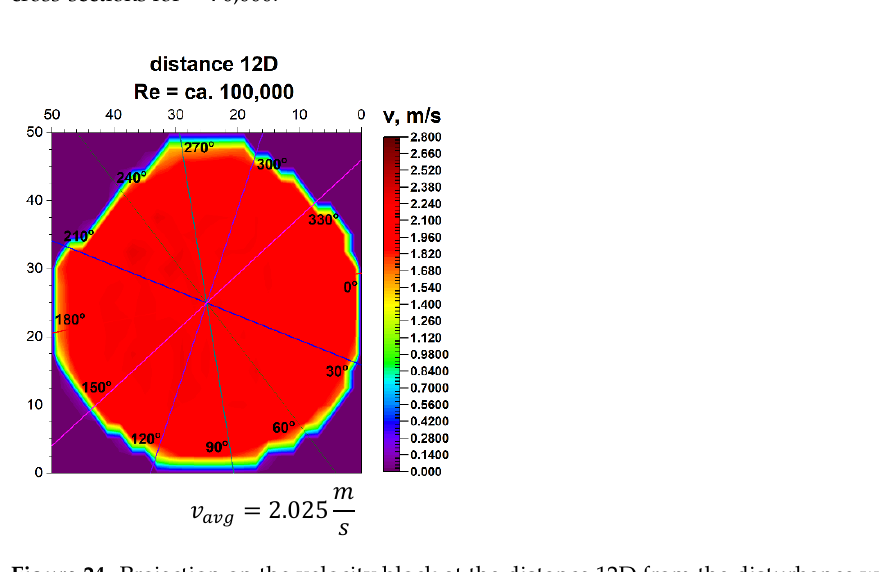
Figure 23. Projection on the velocity block at the distance 12D from the disturbance with marked cross-sections for ≅ 70,000.